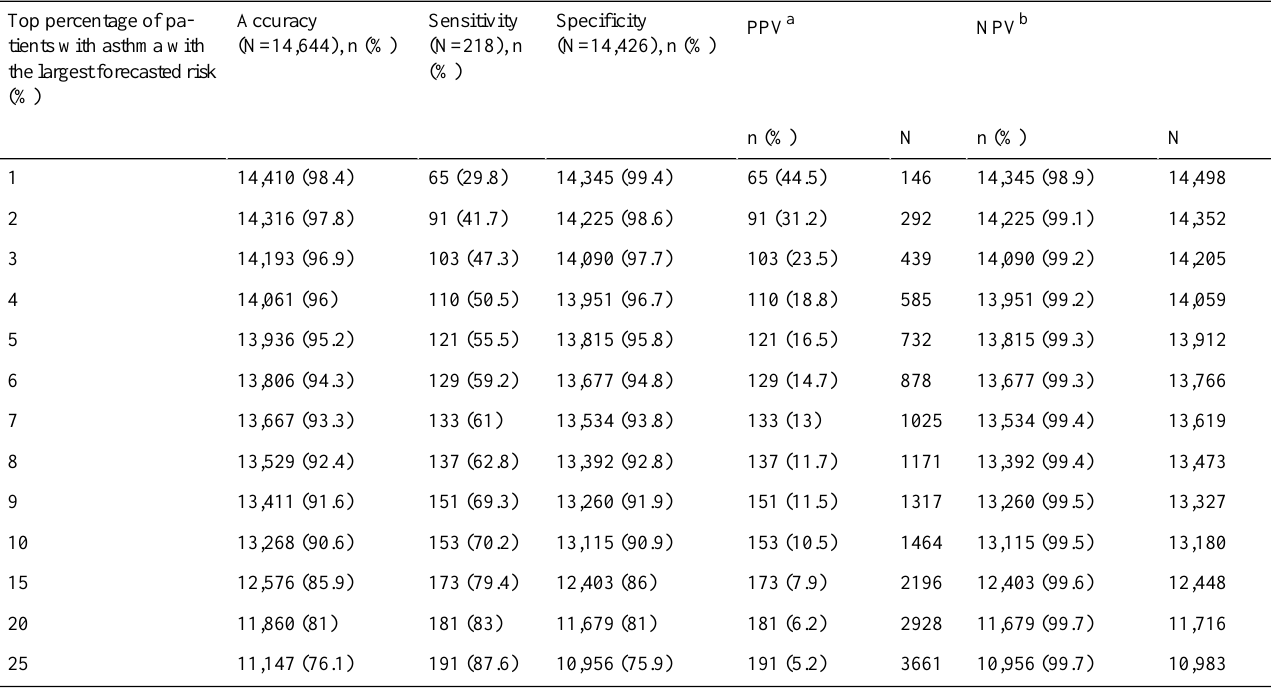
Table 5. Our final UWM model’s performance measures when the cutoff point for making binary classification was placed at different top percentages of patients with asthma with the largest forecasted risk.